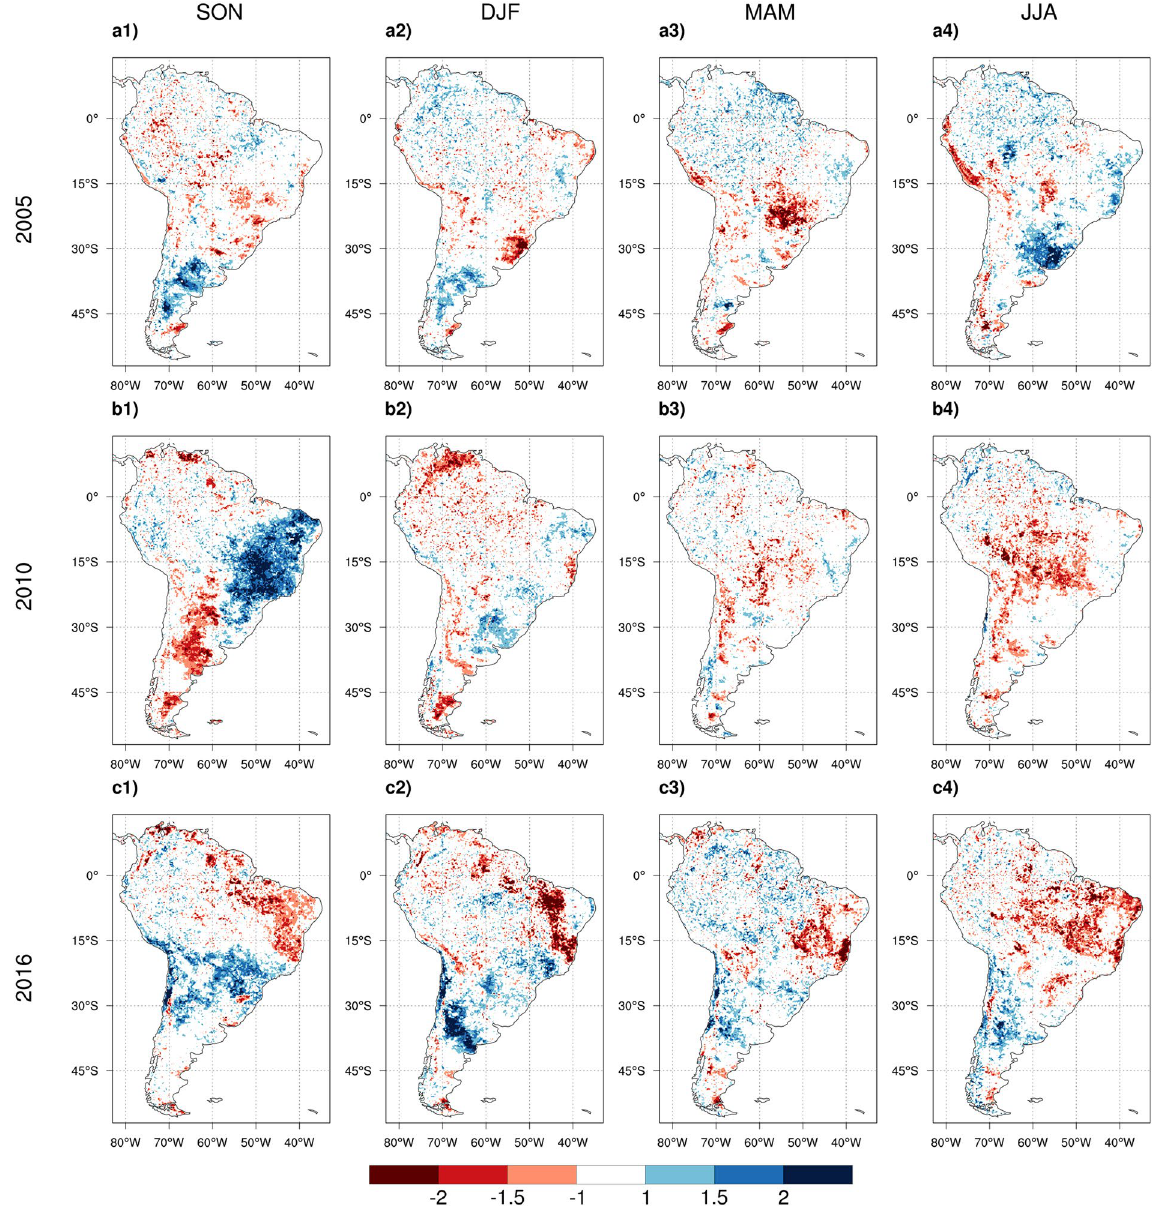
Figure 4. Spatial maps of Normalized Difference Vegetation Index (NDVI) anomalies calculated using NASA MODIS product over 2003–2017. The seasonal anomalies are shown for the three extreme droughts of 2005 ( a1,a2,a3,a4 ), 2010 ( b1,b2,b3,b4 ), and 2016 ( c1,c2,c3,c4 ). Seasonal cycles for each year start from September of the previous year (e.g. SON 2004 for 2005 seasonal cycle). Figures created with: The NCAR Command Language (Version 6.3.0) [Software]. (2016). Boulder, Colorado: UCAR/NCAR/CISL/TDD. http://dx.doi.